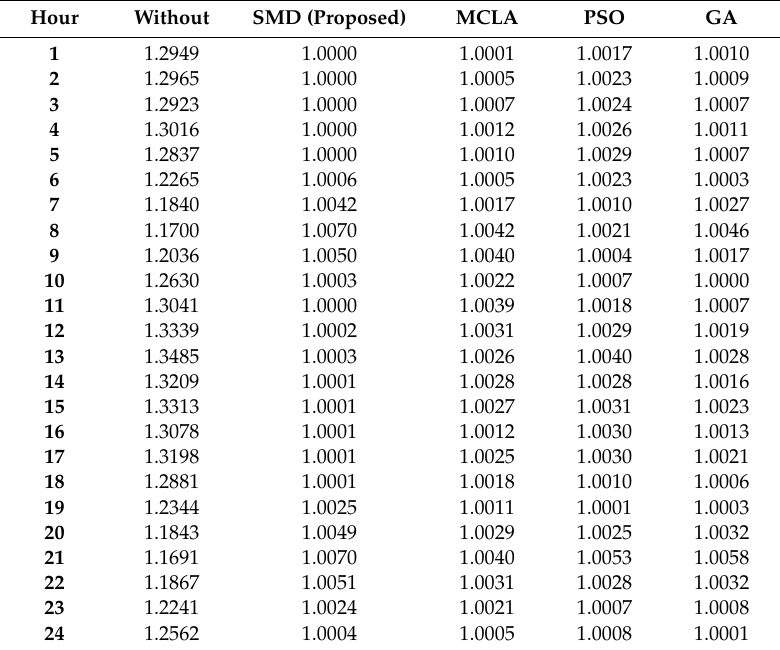
Table A2. Comparison between the hourly UC calculated with di ff erent algorithms at the SP level.